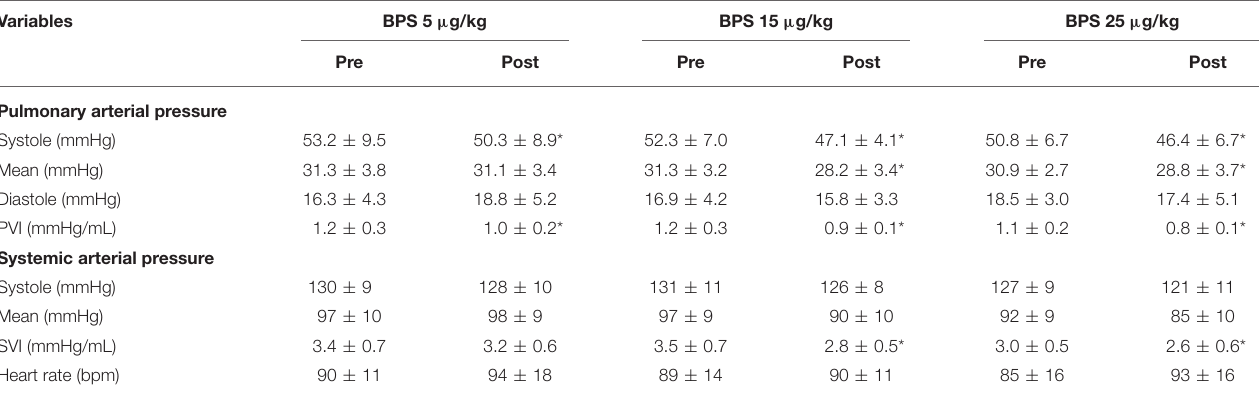
TABLE 2 | Changes in hemodynamic parameters before and after beraprost sodium administration.